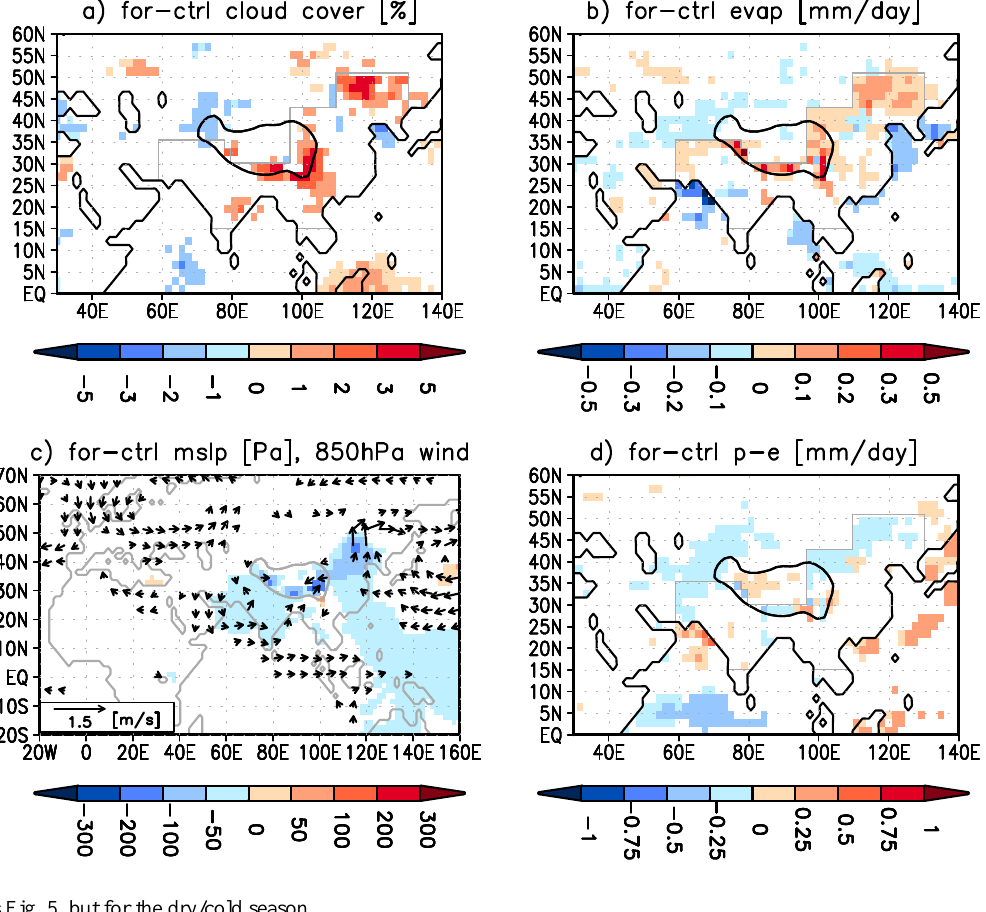
Fig. 6. Same as Fig. 5, but for the dry/cold